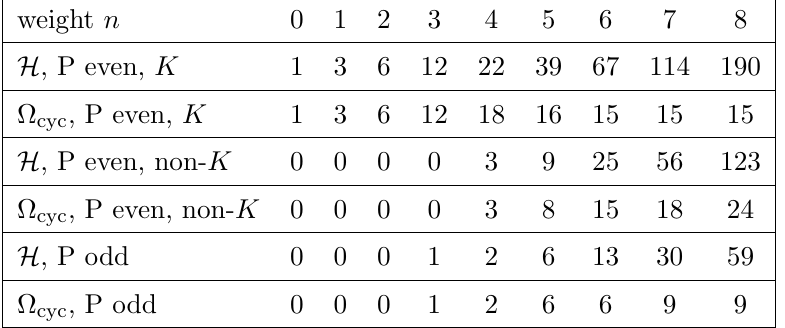
Table 4 . Dimension of the full weight- n hexagon function space H , decomposed into even and odd subspaces under parity P, and compared with the corresponding dimensions for (cid:10) cyc . In the P-even sector we divide the space into non- K and K